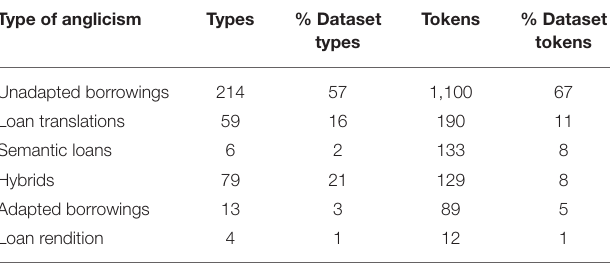
TABLE 3 | Total anglicism types and tokens for the dataset per type of borrowing, rounded to the nearest whole number.